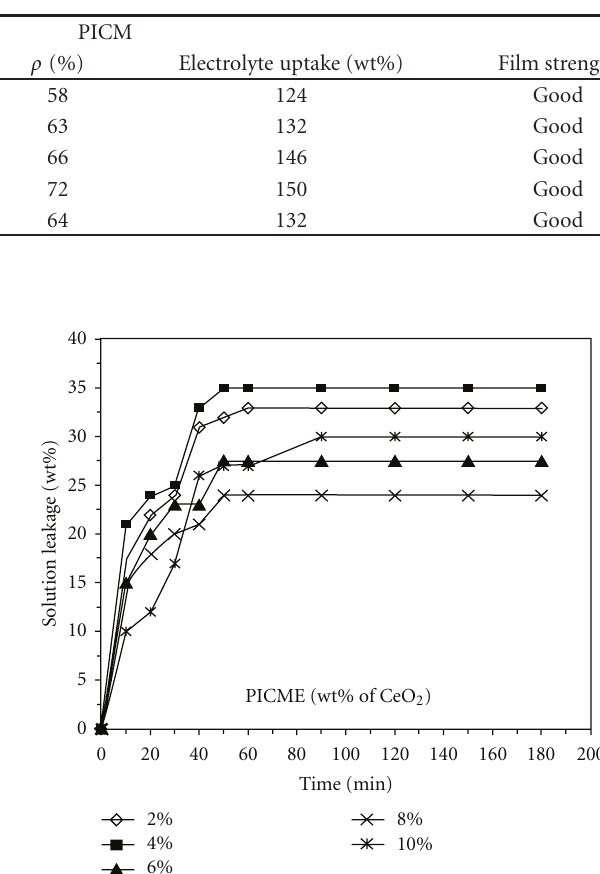
Table 2: Thermal and other physical properties of composite microporous membranes obtained by conventional phase inversion method (PICM).